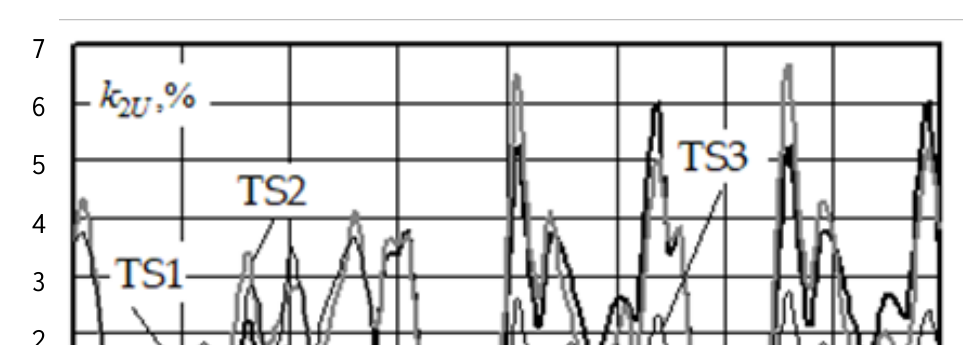
Figure 15. Current profile of a train weighing 5000 tons.